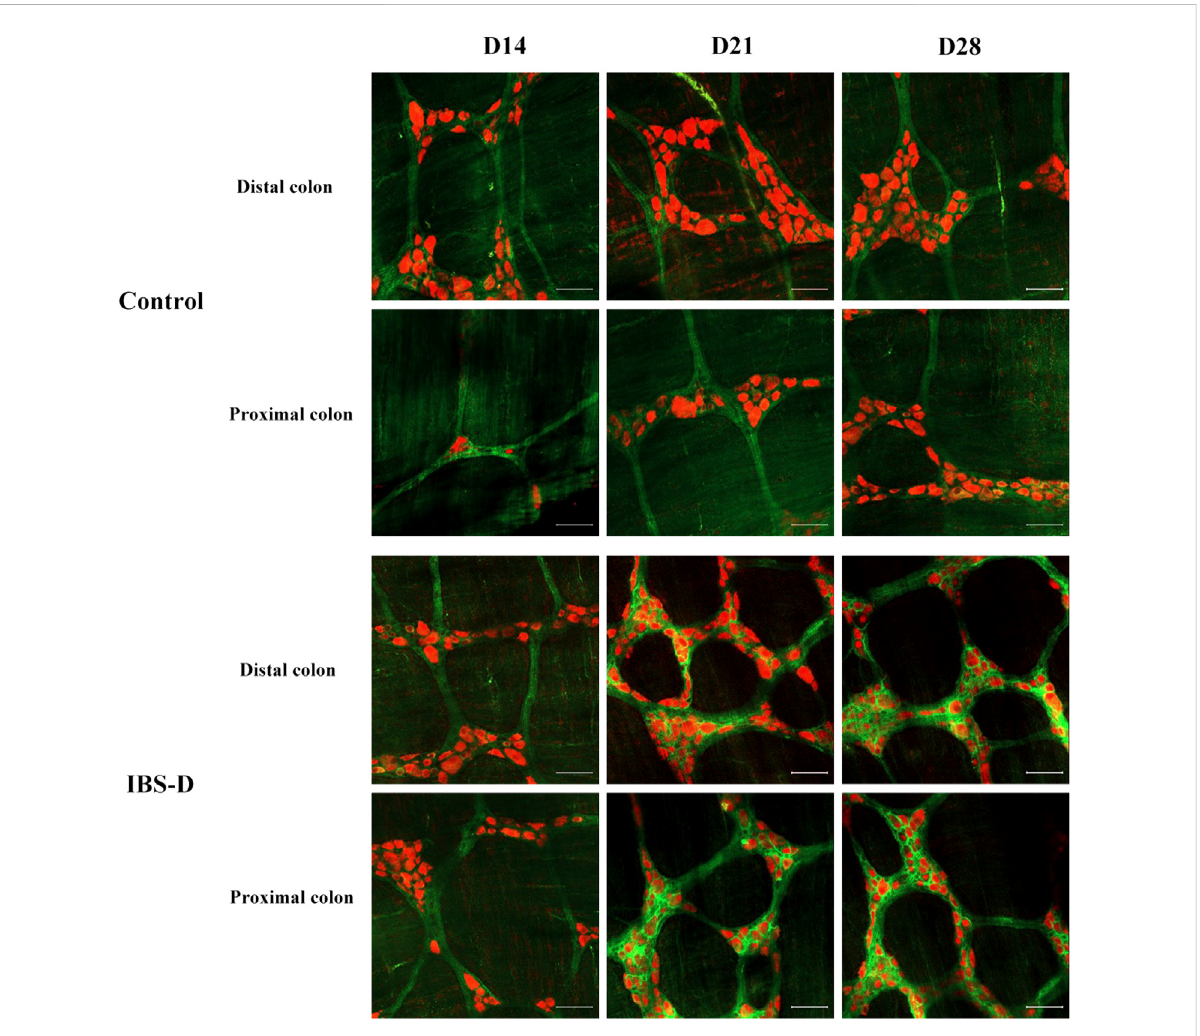
FIGURE 7 Choline acetyltransferase (ChAT) is altered in IBS-D rats. ChAT proteins photographed by laser confocal microscopy. Immuno fl uorescence results of ChAT positive neurons in the proximal and distal colon of IBS-D rats at day 14, day 21, and day 28. HuC/D (Red), ChAT (Green). Scale Bar = 50 μ